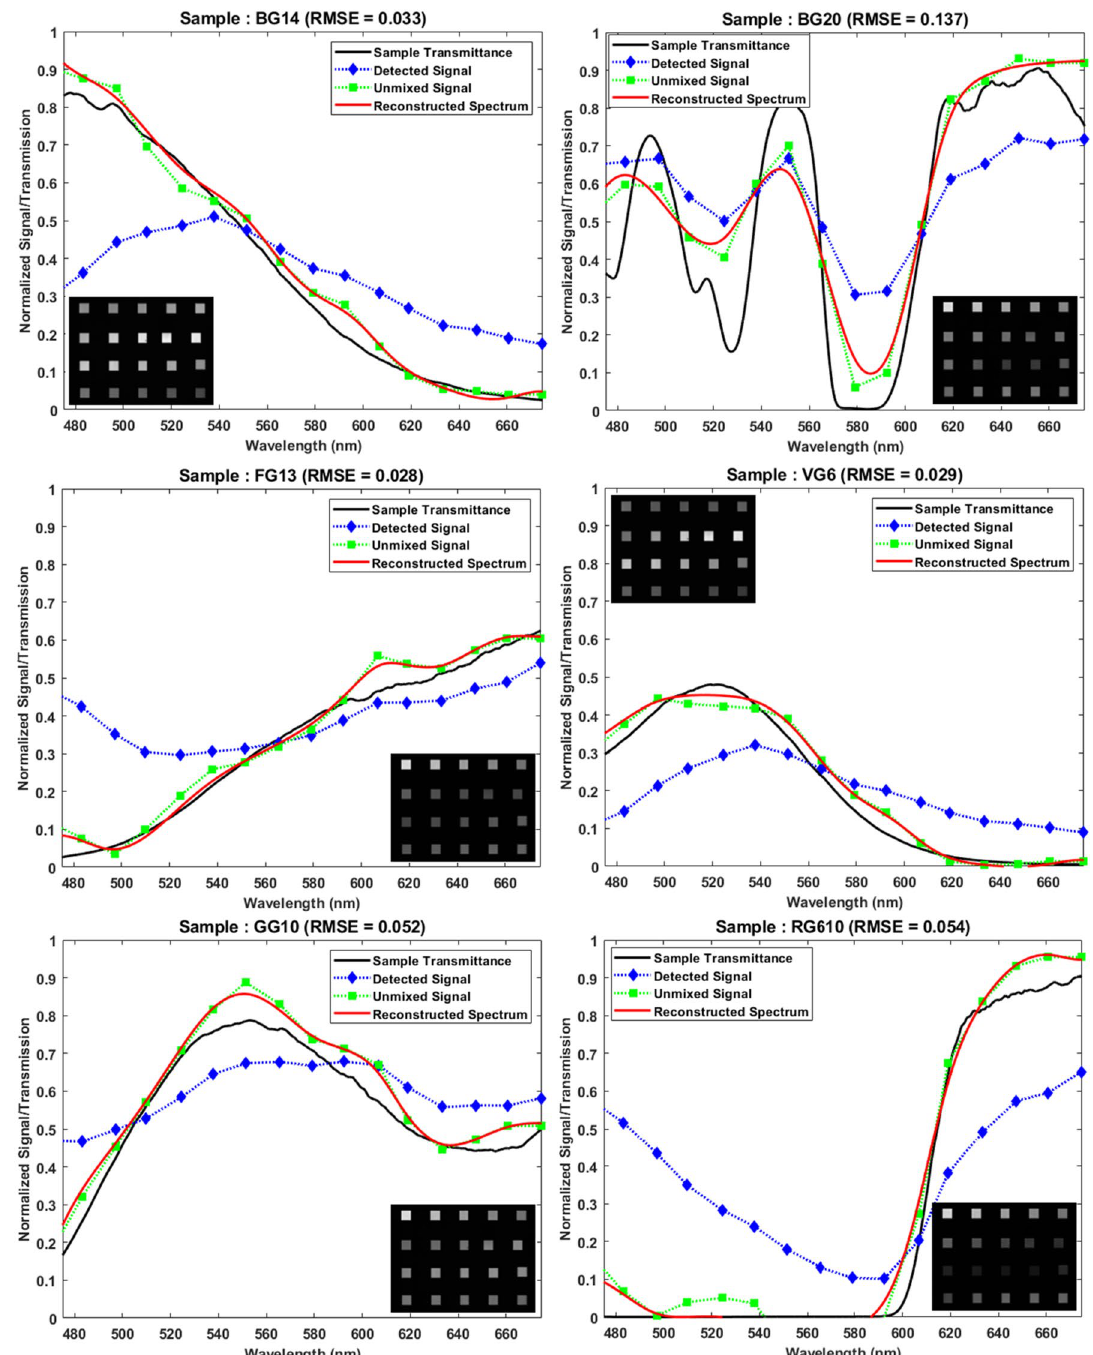
Figure 5. Results of spectral reconstruction of 6 samples using snapshot images (shown in insets) through the color filter array. Black curves show sample transmission (ground truth), blue curves show the signal extracted from images, green curves show the signals after unmixing algorithm and red curves show the reconstructed